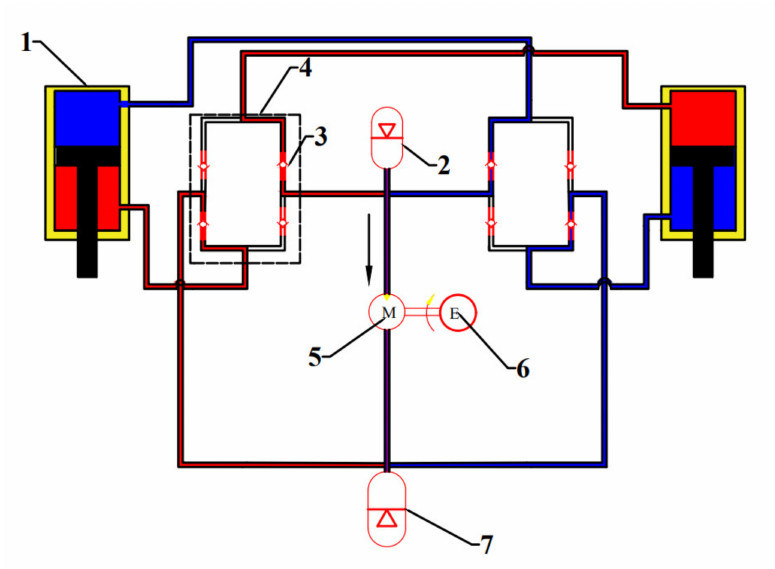
Figure 1. The structure and working principle of the HIIRS. 1 hydraulic cylinder; 2 high-pressure accu- mulator; 3 check valve; 4 hydraulic rectifier; 5 hydraulic motor; 6 generator; 7 low-pressure